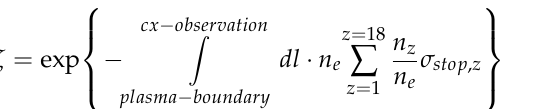
(a) (b) Figure 4. ( a ) ITER diagnostics neutral beam (DNB) power density profile in vertical direction versus distance from duct position (plasma-entry); ( b) ITER DNB power density profile in horizontal direction versus distance from duct position (plasma-entry). 2.3. SOS Continuum Radiation Modeling The underlying plasma continuum spectrum is integral part of any fusion spectrum, in fact in the ITER case it is the dominant light source, typically orders of magnitudes above the expected CXRS spectra. Historically, the plasma continuum radiation (cf. [42]) which is a common light source accessible to all visible spectroscopic diagnostics, is frequently used as in-situ calibration source enabling a consistent integrated data analysis. The calculation of line-of-sight integrated free-free